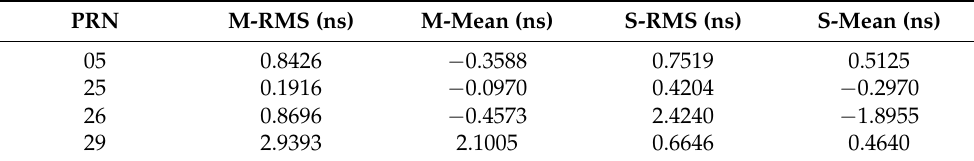
Table 1. Satellite DCB RMS and mean differences between satellite DCB estimates from 16 August 2017, using the multi-station method, single-station method and CODE for 15 min data. PRN